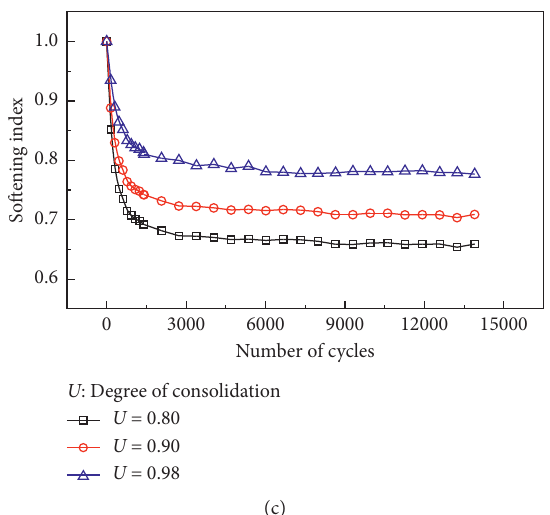
Figure 7: Degree of consolidation effect on the softening index of SRM: (a) P � 20% and σ ′ � 400kPa. (c) P � 20% and σ 3